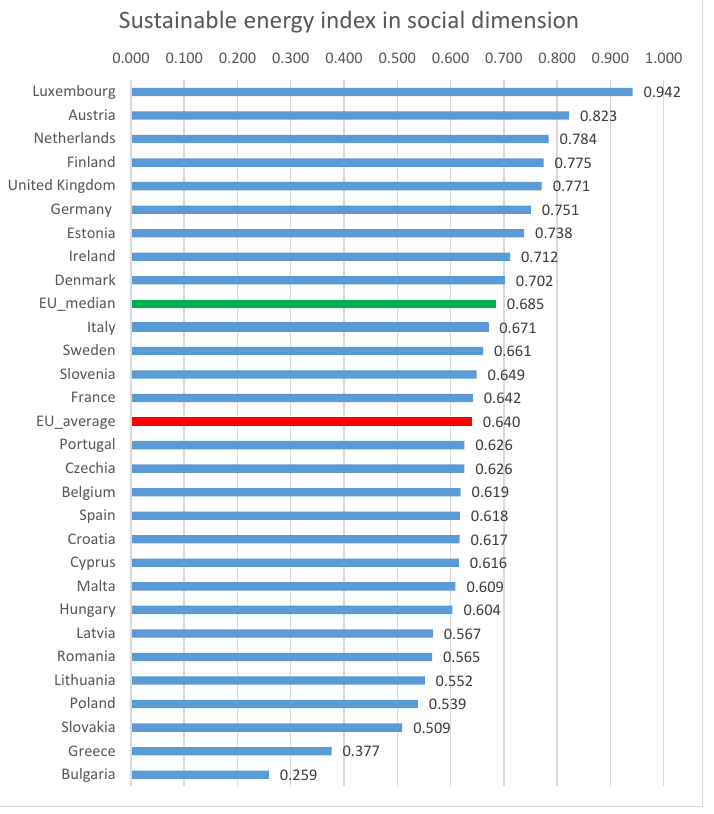
Figure 1. Social dimension index of sustainable energy in 2017 for the EU-28 Member